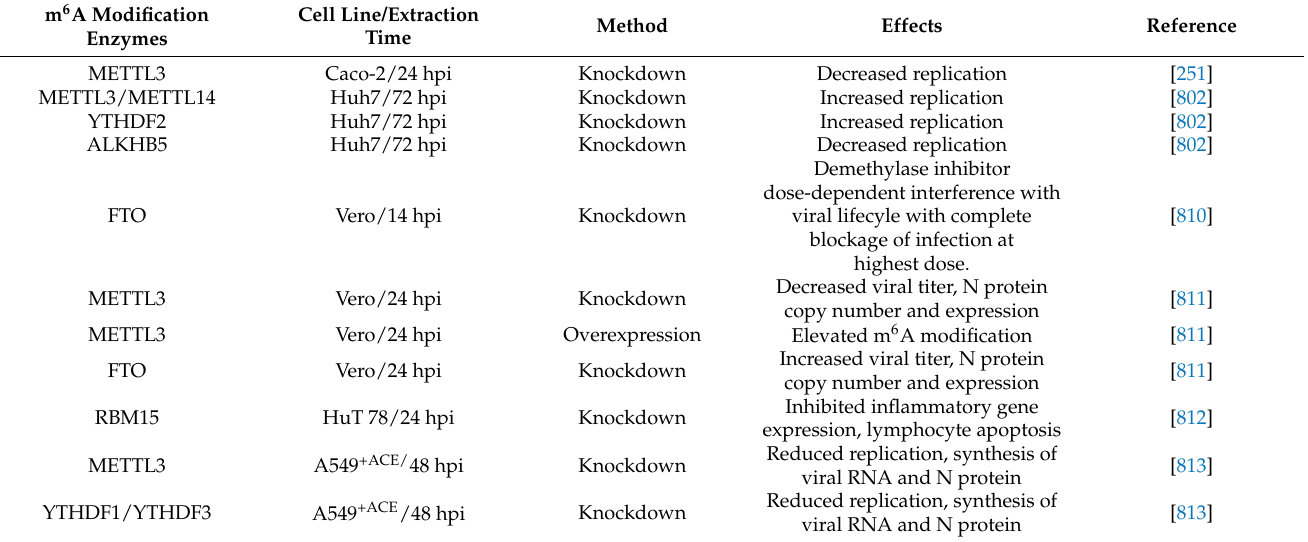
Table 1. The in vitro effects of m 6 A modifications by methyltransferases METTL3/METTL14, “read- ers” YTHDF1/2/3, and demethylases ALKHB5/FTO on SARS-CoV-2 viral replication and protein ex-